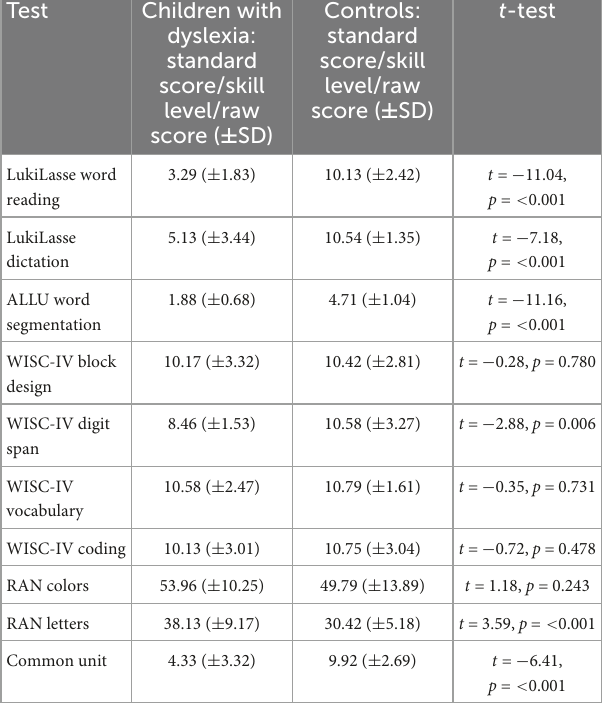
TABLE 1 Participants’ literacy, cognitive, and phonological skill